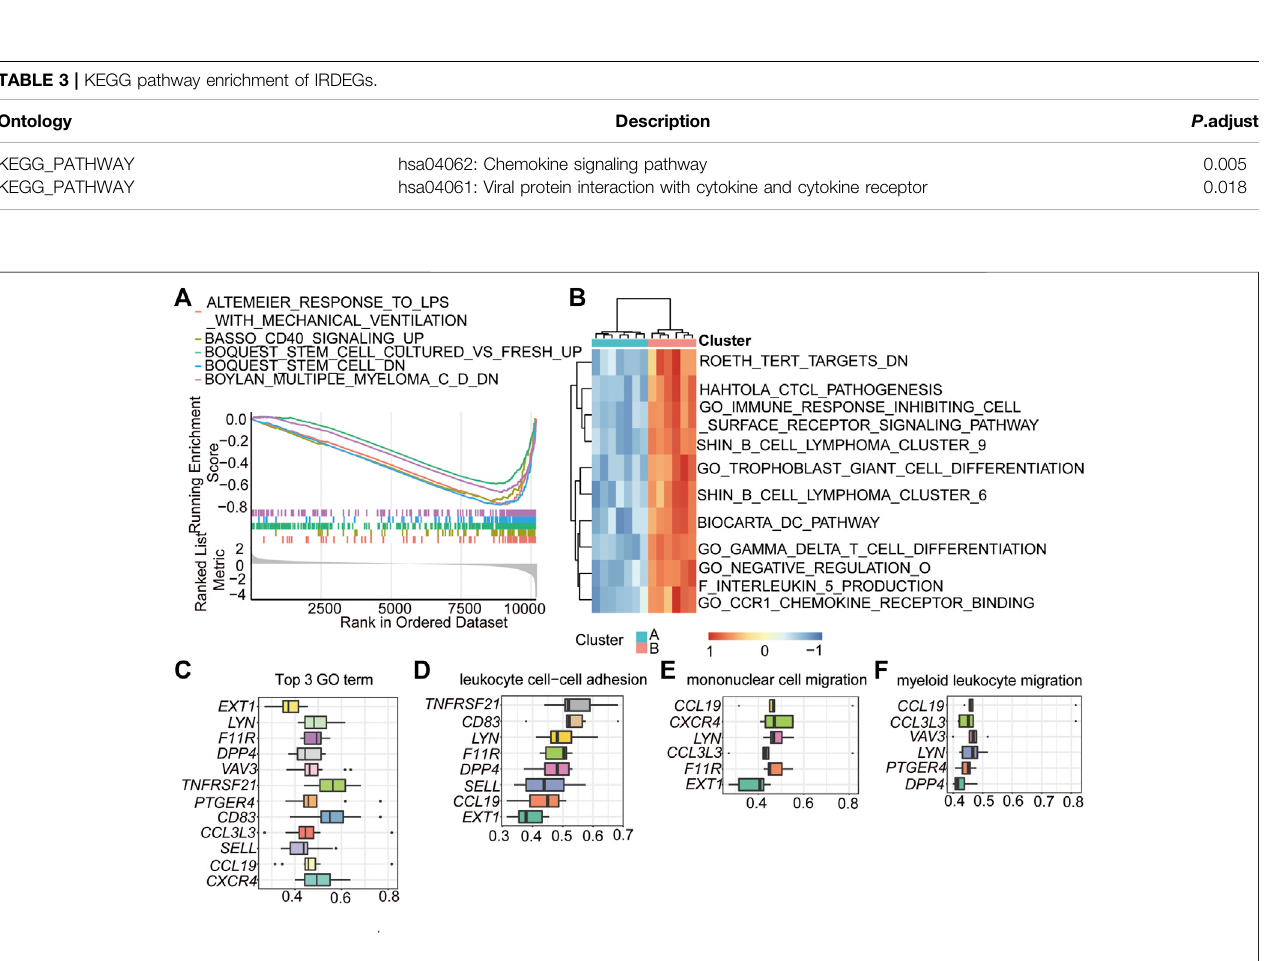
FIGURE6| GSEAandGSVAenrichmentanalysisofthetwoimmune-relatedclusters. (A) GSEAshowingthetop5enrichedpathwaysinHALLMARKsetofcluster 2. Each line represents a particular term in a unique color. The up-regulated genes located near the left, while the down-regulated genes located near the right. The thresholdwasFDRq < 0.06. (B) GSVAshowingthetop10pathwaysenrichedinthecluster2. (C) functionalsimilaritiesanalysisofthegenesplayedimportantrolesinthe top 3 biological processes. (D – F) functional similarities analysis of the genes played important roles in leukocyte cell-cell adhesion (D) , mononuclear cell migration (E) , and myeloid leukocyte migration (F)